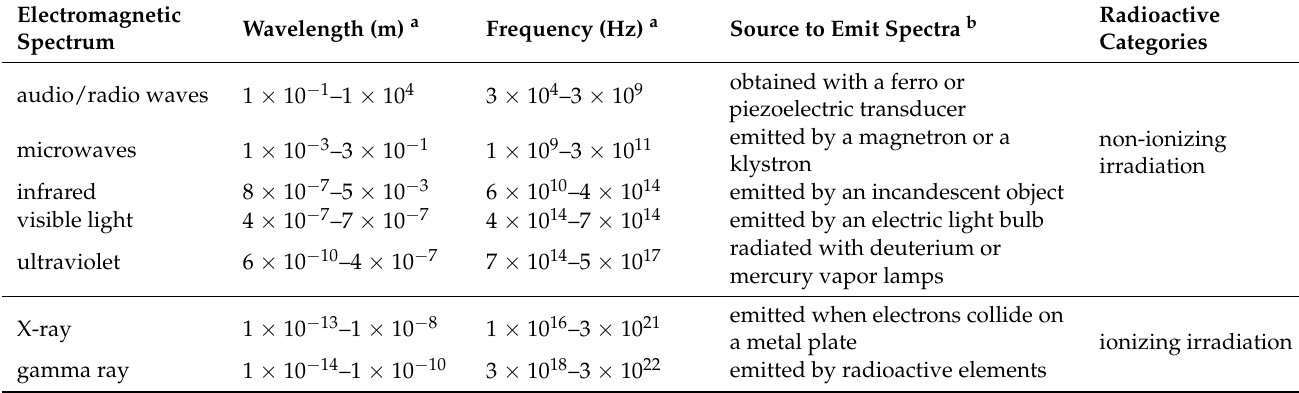
Table 1. Characteristics of electromagnetic